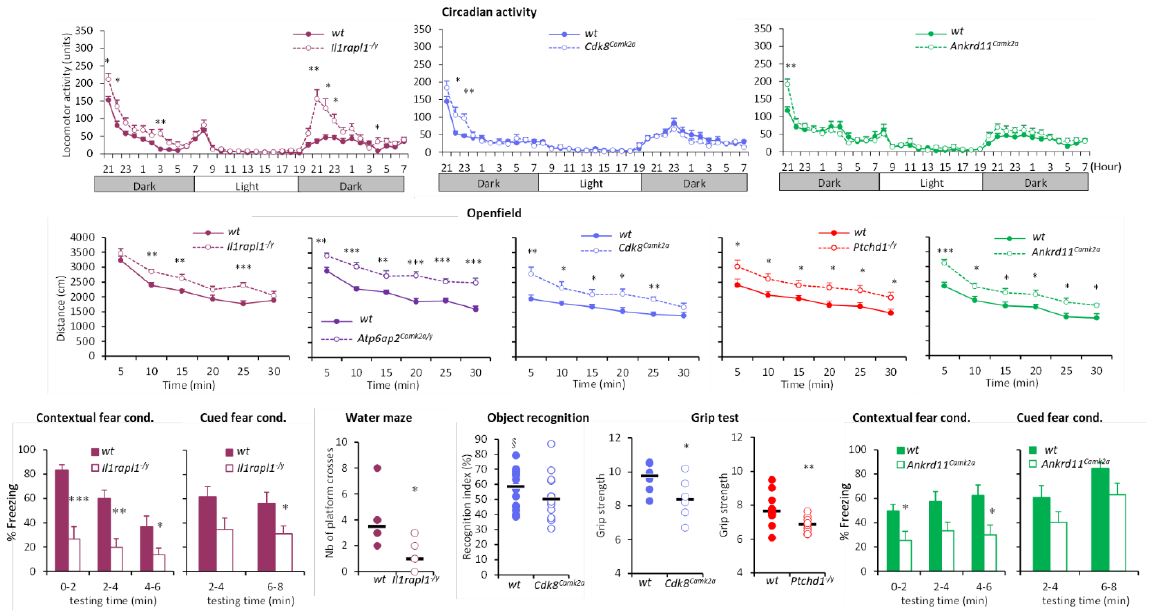
Figure 2. Selected behavioural alterations in the hyperactivity group. Cdk8 Camk2a , Ankrd11 Camk2a , Atp6ap2 Camk2a/y , Ilrapl1 − /y and Ptchd1 − /y [86] showed increased activity in the circadian activity and open field tests reflected by a higher number of beam breaks and distance travelled compared to wild- types. Data are expressed as the mean ± SEM of front and back successive beam breaks (circadian activity) and distance (open field) across time, and analysed using repeated measures ANOVA, followed by t -tests for each time point. Cdk8 Camk2a , Ankrd11 Camk2a , and Ilrapl1 − /y showed altered learning performance in the water maze (decreased number of platform crosses for Ilrapl1 − /y ), fear conditioning (decreased percentage of freezing for Ankrd11 Camk2a and Ilrapl1 − /y ) or object recognition ( Cdk8 Camk2a ), or motor deficits in the grip test ( Cdk8 Camk2a and Ptchd1 − /y ). Data are expressed as mean ± SEM% freezing (fear conditioning), or scattergrams with the median for number of platform crosses (water maze), recognition index (object recognition), or muscle strength (grip test), and analysed using either repeated measures ANOVA followed by t -tests, or Student t -tests for single time points. * p < 0.05, ** p < 0.01, *** p < 0.001 vs. WT; § p < 0.05 vs. the chance level (only WT displayed good performance while mutants performed at the hazard level).